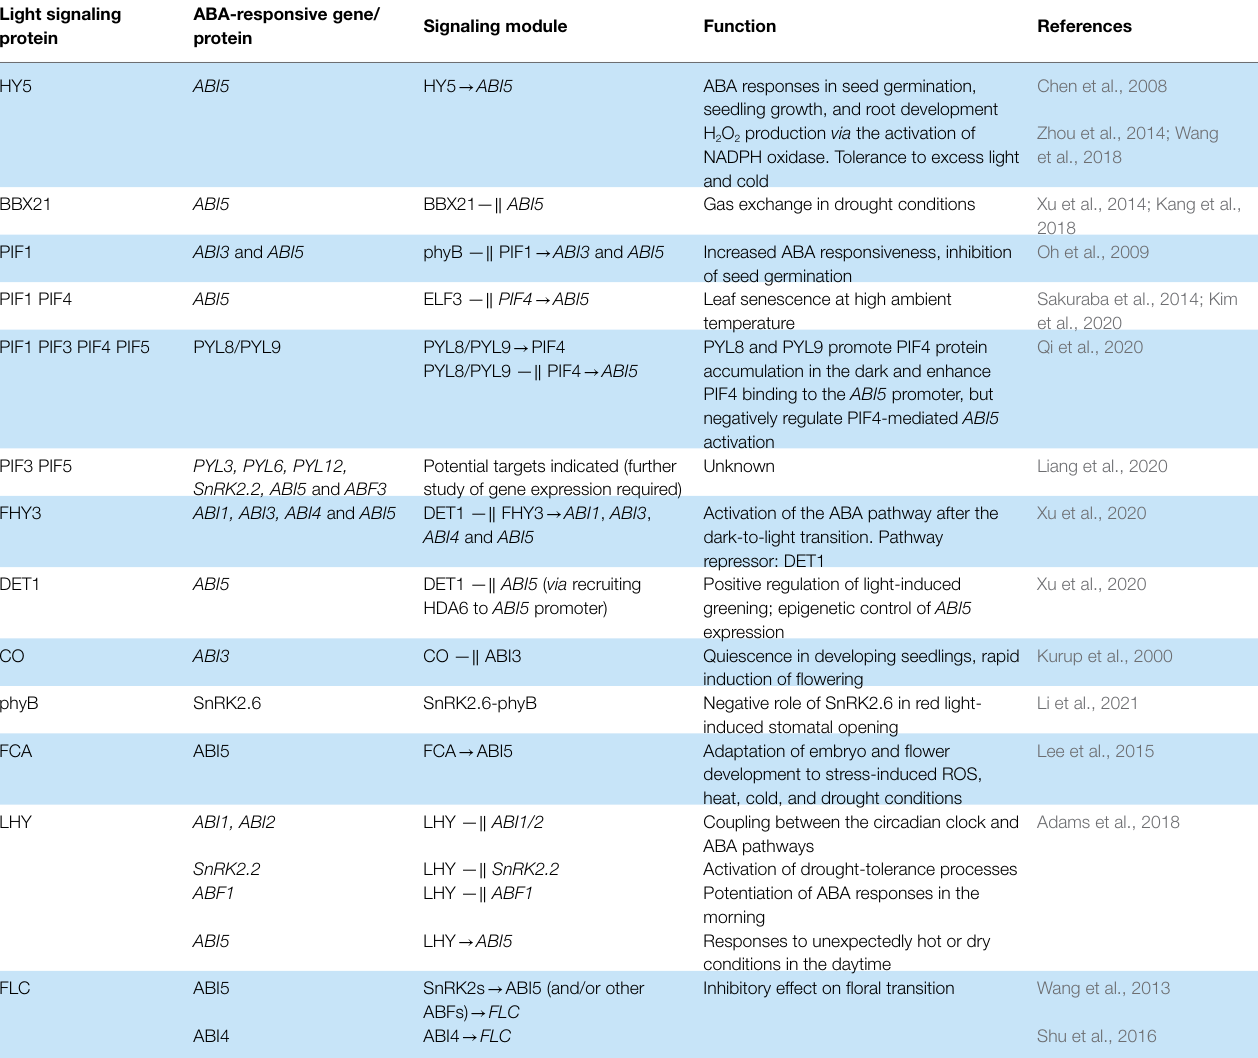
TABLE 1 | ABA–light integrative modules and their functional significance. Light signaling